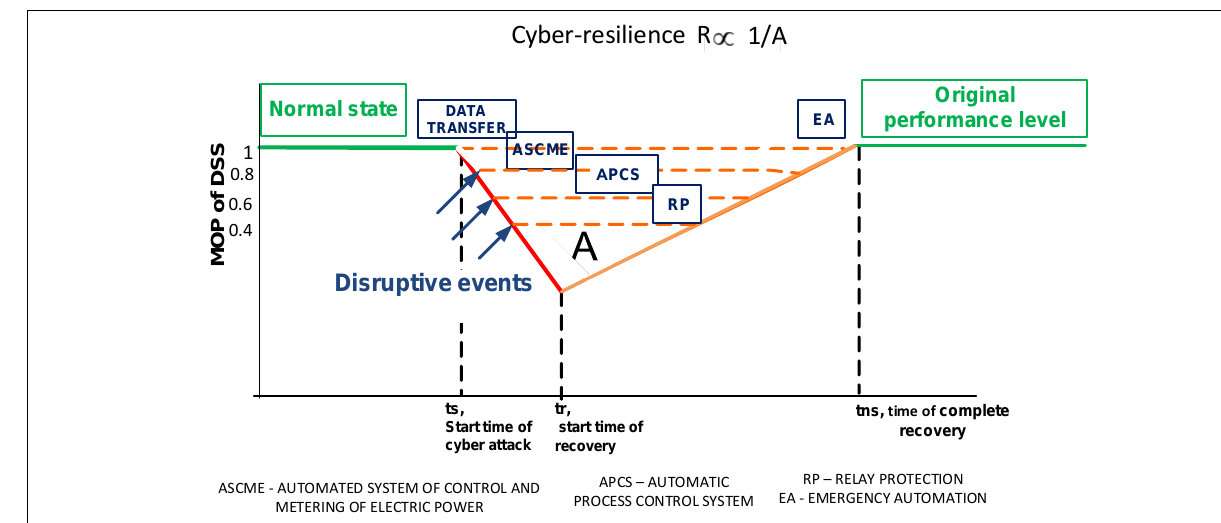
Fig. 4. Sequence of DSS components failures due to cyber attacks.